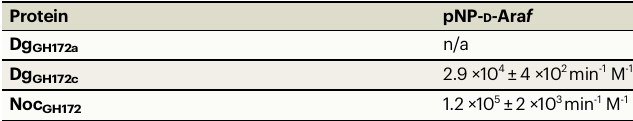
Table 3 | SEC-LS oligomerization state of GH172 enzymes